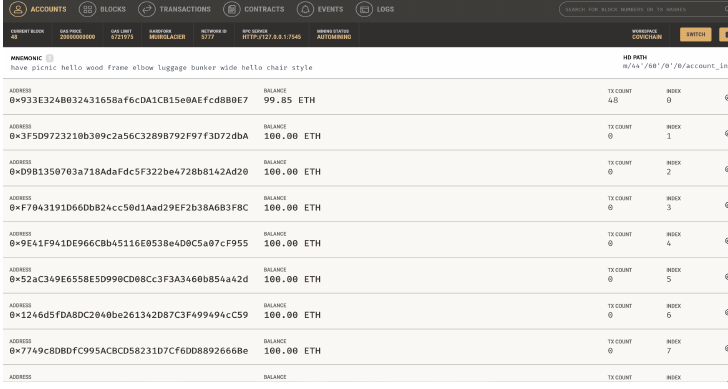
Figure 7. Ganache local blockchain.